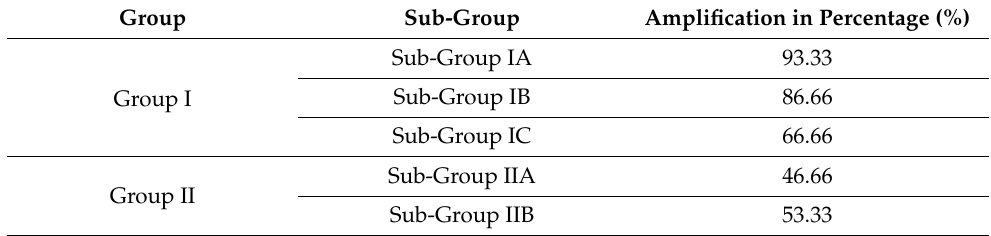
Table 9. PCR amplification in different study